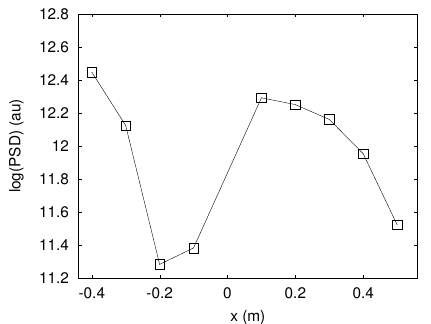
Figure 8. Mode computed from the